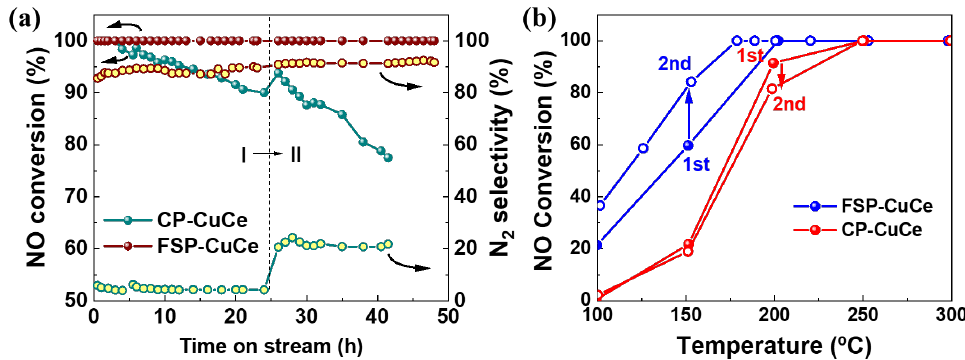
Figure 2. Stability test of typical catalysts: ( a ) The stability of FSP-CuCe and CP-CuCe catalysts at different conditions (I: 200 °C with GHSV = 15,000 mL/(g·h) and II: 250 °C with GHSV = 60,000 mL/(g·h); ( b ) NO reduction performance of FSP-CuCe and CP-CuCe catalysts in two test cycles (first is solid and second is hollow) in NO + CO reaction.